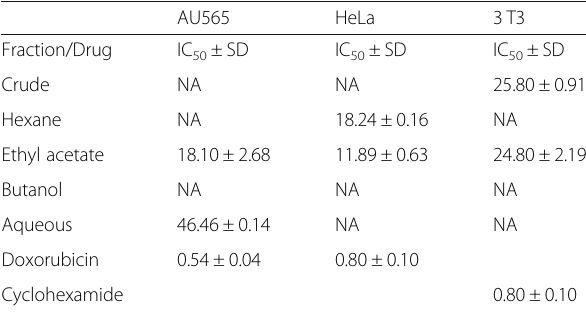
Table 4 Immunomodulatory activities of methanolic crude extract and fractions A. precatorius